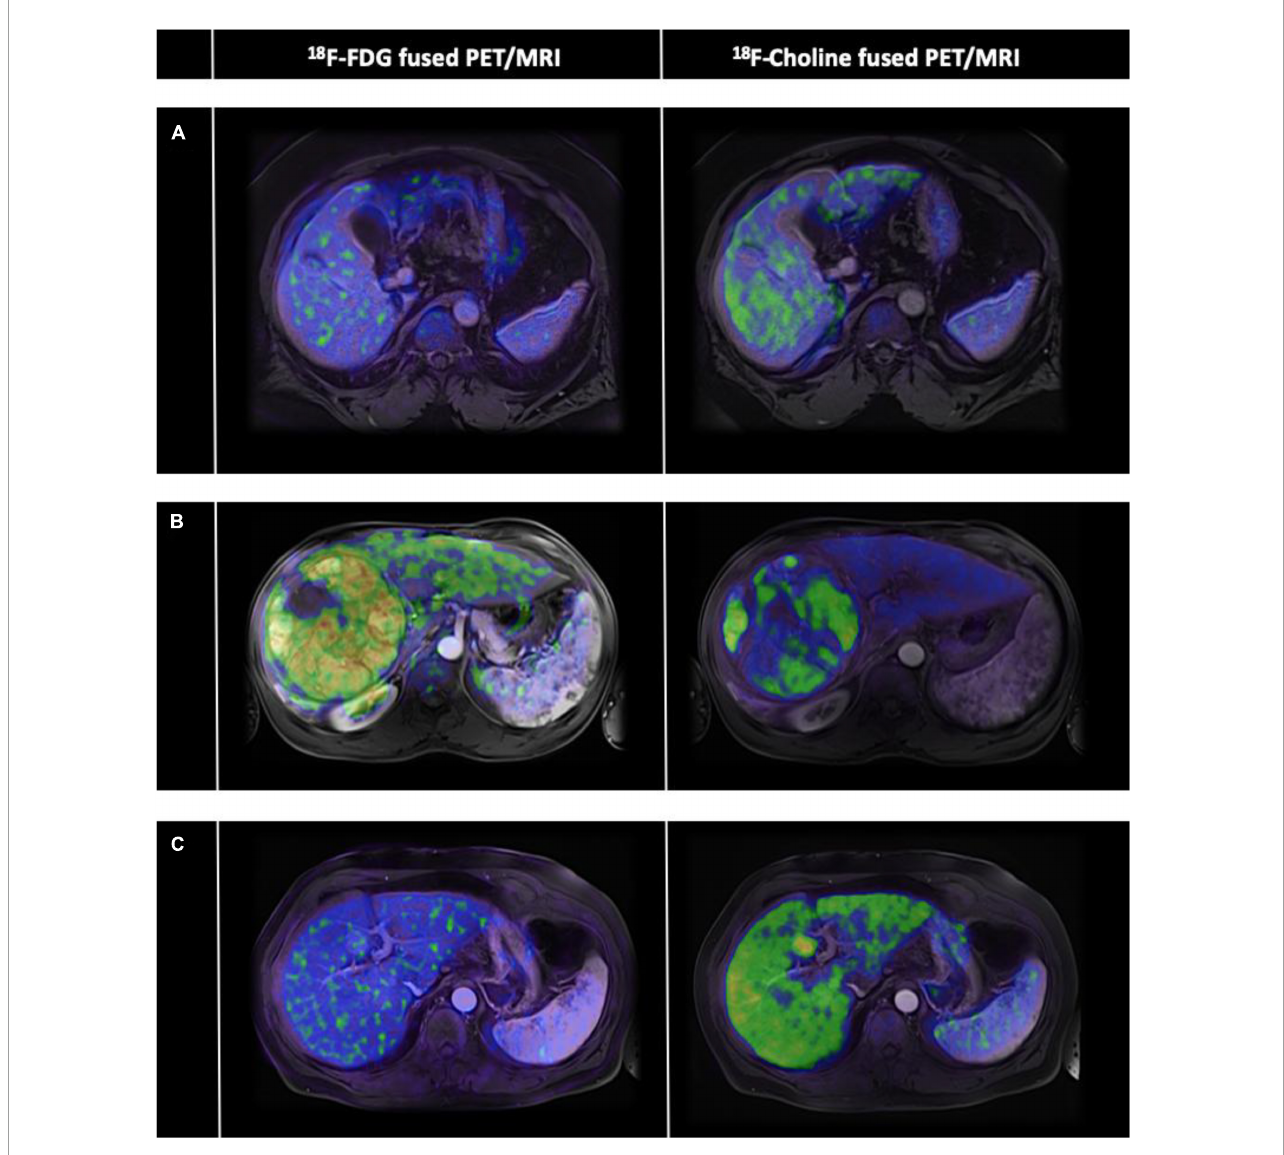
FIGURE2 Case-mix of hepatocellular carcinoma (HCC) with various dual-tracer positron emission tomography (PET) profiles. The PET part of the non-contrast-enhanced PET/computed tomography (CT) data 18F fluorodeoxyglucose (18F-FDG on the left panel and 18F-choline on the right panel) of three HCCs (A–C) were retrospectively fused to their available contrast-enhanced MRI data (axial T1-weighted MRI pulse sequences with arterial phase contrast enhancement). (A) Dual-PET radiotracers negative uptake (HCC Grade III, with mVI). (B) Dual-PET radiotracers positive uptake (HCC Grade I, with mVI). (C) Negative 18F-FDG uptake but positive 18F-choline uptake (HCC Grade I-II, without